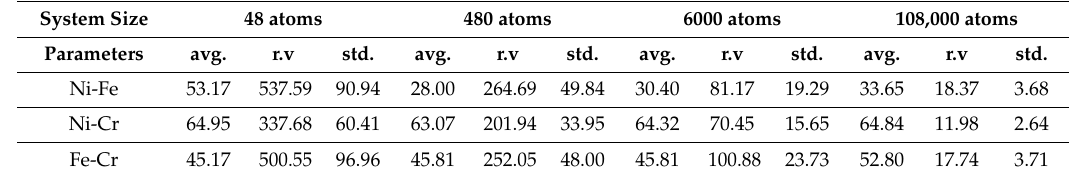
Table 1. SFE average (avg.), range of variation (r.v) and standard deviation (std.) for Ni 50 -Fe 50 compositions obtained from 100 di ff erent structures each for 48, 480, 6,000 and 108,000-atom supercells. System Size 48 atoms 480 atoms 6000 atoms 108,000 atoms Parameters avg. r.v std.